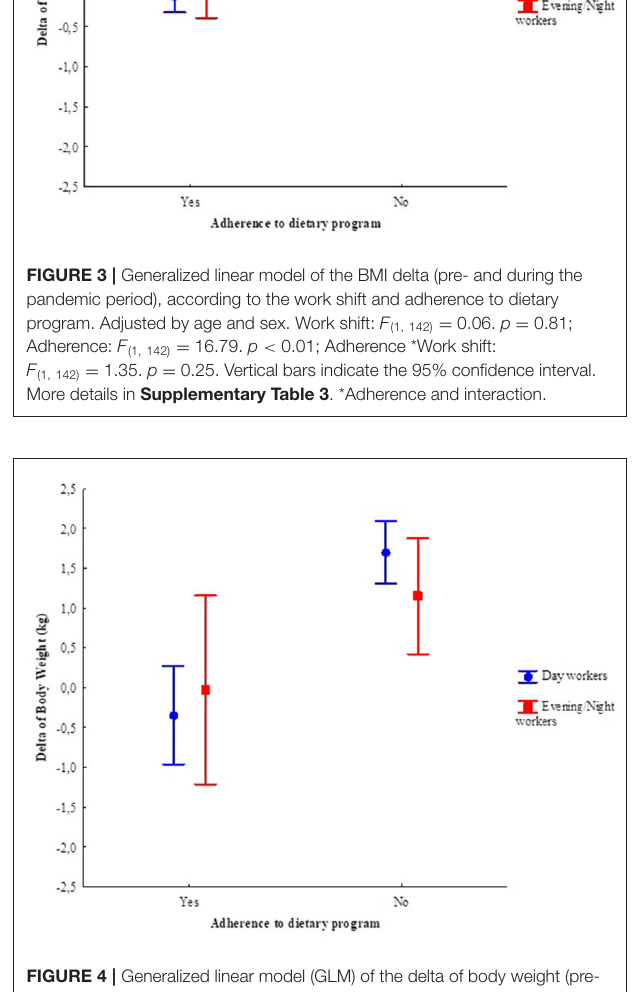
FIGURE 4 | Generalized linear model (GLM) of the delta of body weight (pre- and during the pandemic), according to the work shift and adherence to dietary program. Adjusted by age and sex. Work shift: F (1, 142) = 0.08. p = 0.78; Adherence: F (1, 142) = 16.81, p < 0.01; Adherence *Work shift: F (1, 142) = 1.22, p = 0.27. Vertical bars indicate the 95% confidence interval. More details in Supplementary Table 4 . *Adherence and